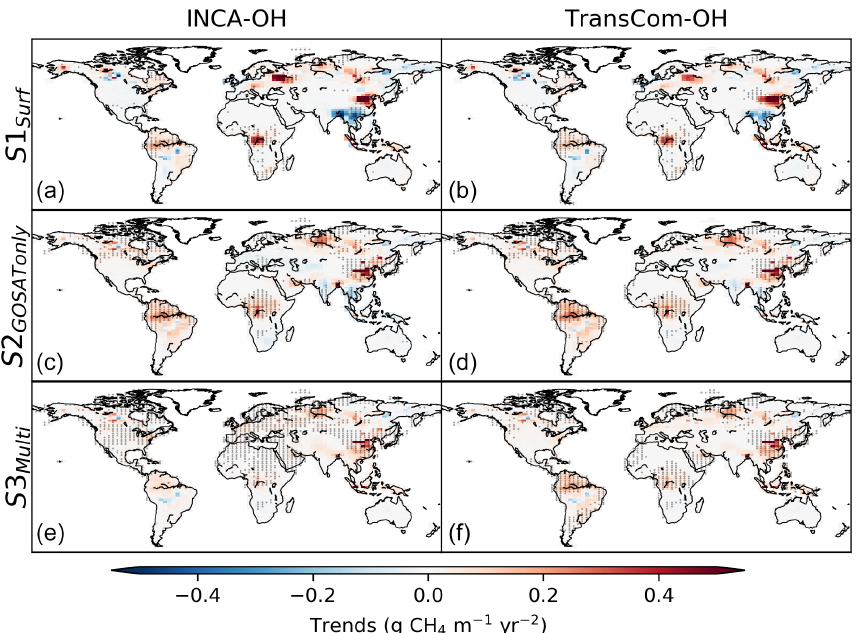
Figure 5. Spatial distribution of trends in the posterior CH 4 emissions from 2010 to 2017. Panels (a) , (c) , and (e) show results using INCA- OH and panels ((b) , (d) , (f) use TransCom-OH. Each row represents one type of observational constraint. The black crosses denote trends that are statistically significant at a 95% confidence level.